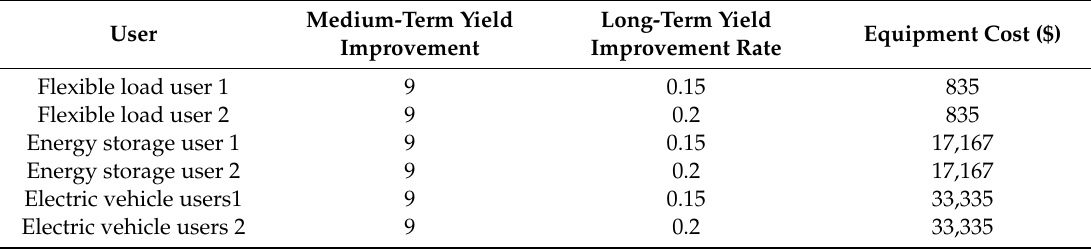
Table 5. Differential parameters for medium- and long-term response. Table 5. Di ff erential parameters for medium- and long-term